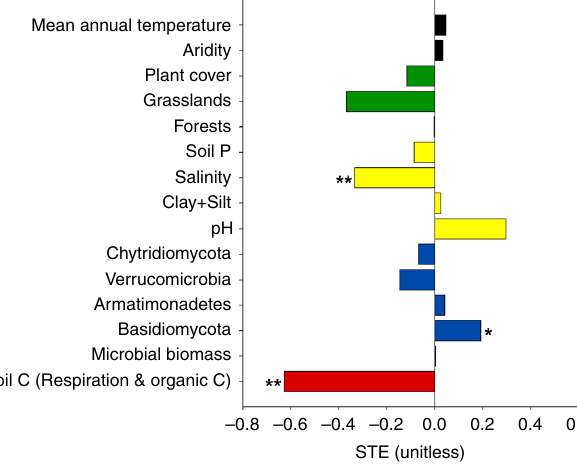
Fig. 4 Standardized total effects (STE) from the Structural Equation Model (SEM). Sum of direct and indirect effects of multiple ecological predictors on the apparent soil priming effect ( n = 69). Soil carbon (C) represents the sum of the standardized effect of soil organic C (SOC) and microbial respiration rates, which re fl ects SOC which is respired by microbes. * p < 0.05, ** p <